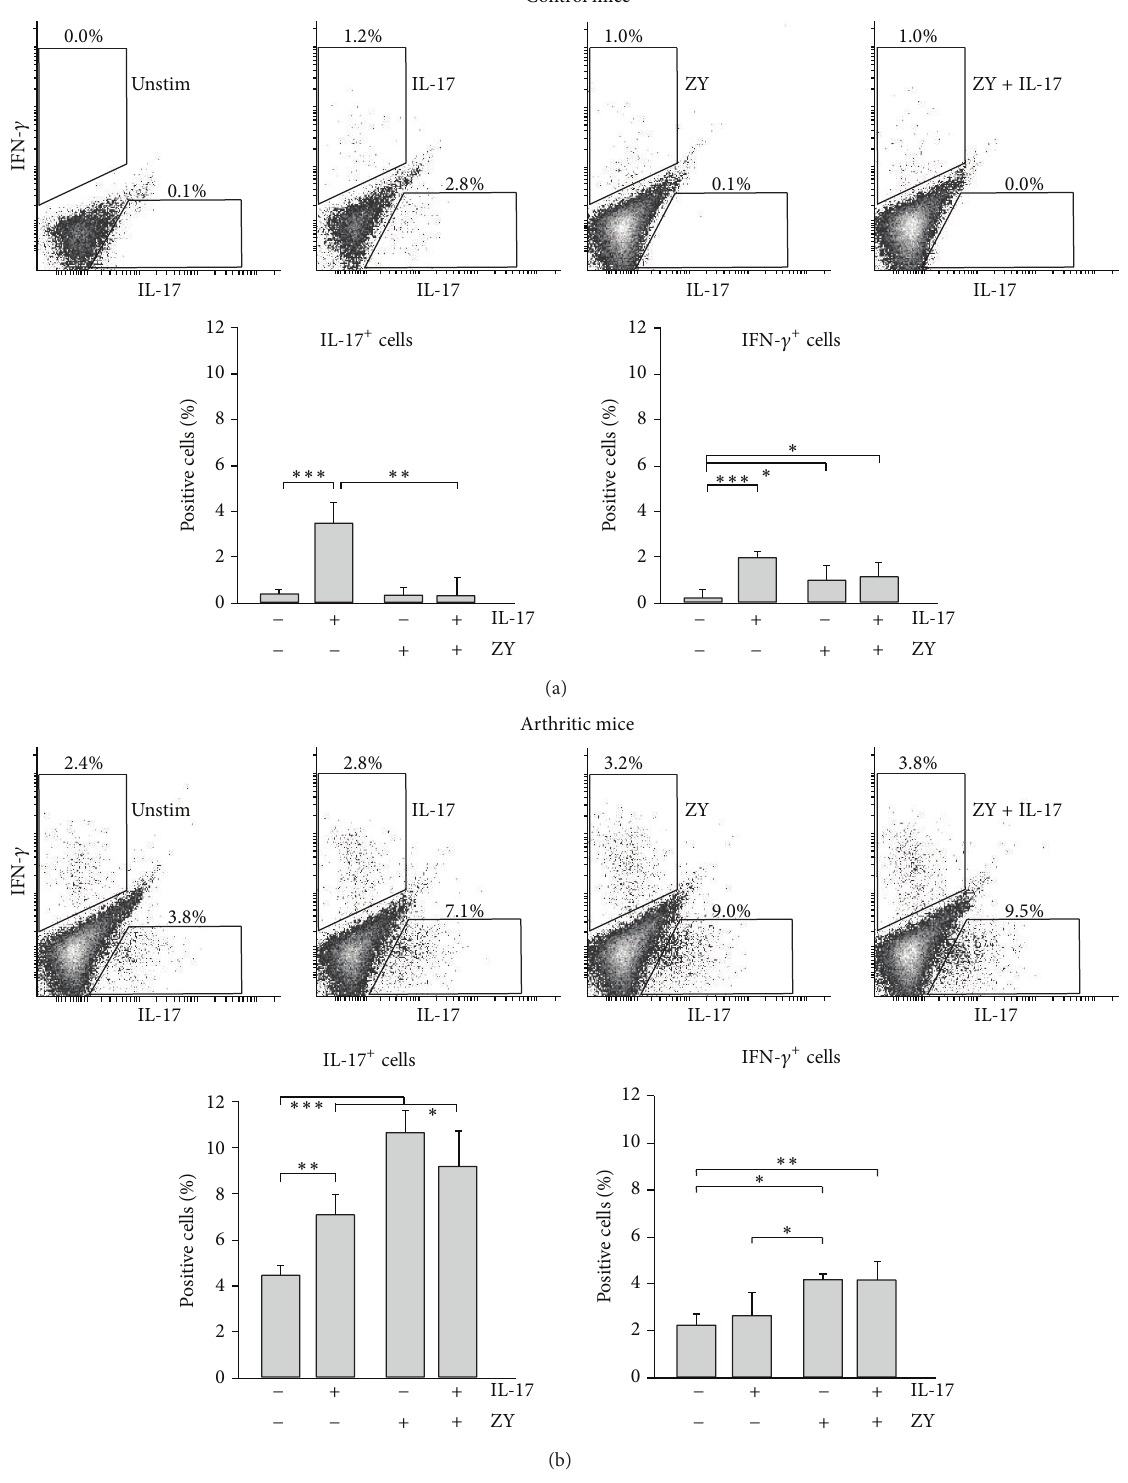
Figure3:Ly6G + CD11b + cellsfromarthriticmiceproducedIL-17andIFN- 𝛾 .Purifiedbloodneutrophilswerecultured(1 × 10 6 /mL)inmedium with GM-CSF (50 ng/mL) and stimulated with zymosan (20 𝜇 g/mL) or/and IL-17 (40ng/mL) for 24 hours. Intracellular IL-17 and IFN- 𝛾 production was evaluated by flow cytometry. (a) Ly6G + CD11b + cells were IFN- 𝛾 − /IL-17 − as shown on dot-plot histograms and graphs. IL-17 induces autocrine IL-17 protein expression and IFN- 𝛾 synthesis in control cells. (b) Dot-plot histograms and graphs show spontaneous IL-17 and IFN- 𝛾 production by Ly6G + CD11b + cells from arthritic group. Zymosan provides stronger signals for IL-17 synthesis than exogenous IL-17 and amplifies the generation of IL-17 + cells. Bars on graphs (a) and (b) represent the mean ± SEM ( 𝑛 = 5 animals/group; 3 experiments). ∗ 𝑃 < 0.05 ; ∗∗ 𝑃 < 0.01 ; ∗∗∗ 𝑃 < 0.001 , Student’s 𝑡